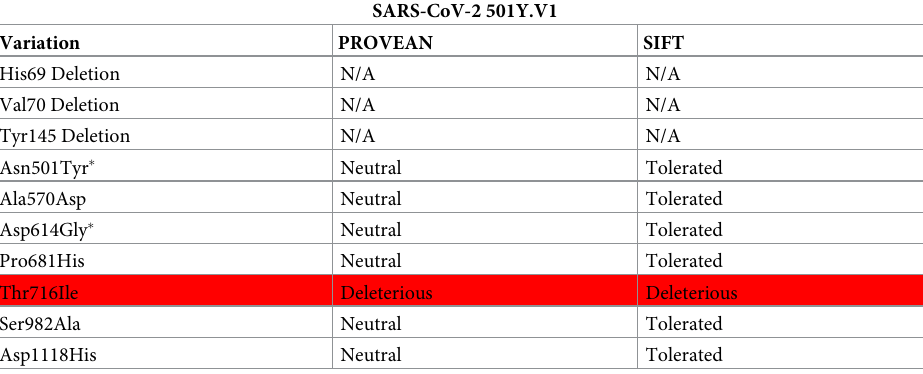
Table 1. Predicted biological impact of mutations in the SARS-CoV-2 501Y.V1 spike